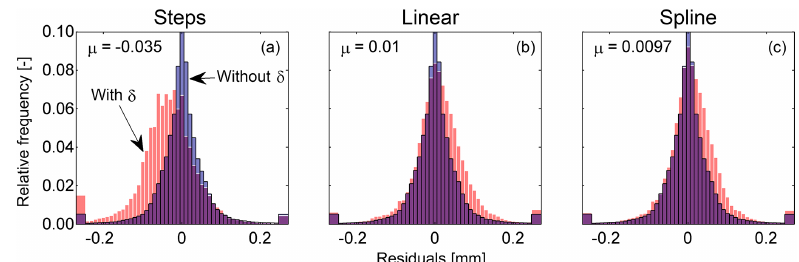
Figure 5. Relative residual frequency distribution for the complete data set and the different interpolation schemes. Blue bars indicate residuals between original and filtered data for the cases with mere smoothing, omitting the threshold values; red bars indicate cases with threshold values and subsequent interpolation. The broad bars at plot edges comprise all residuals greater than 0.25 or smaller than − 0.25mm. Steps: original step interpolation scheme; linear: linear interpolation scheme; spline: cubic Hermitian spline interpolation scheme.